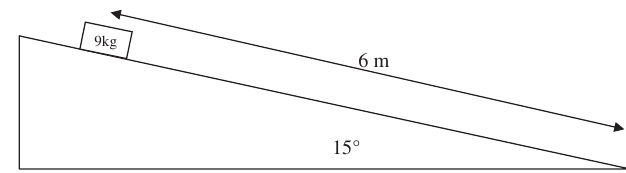
FIG. 5. Diagram of problem posed to Brenda’s